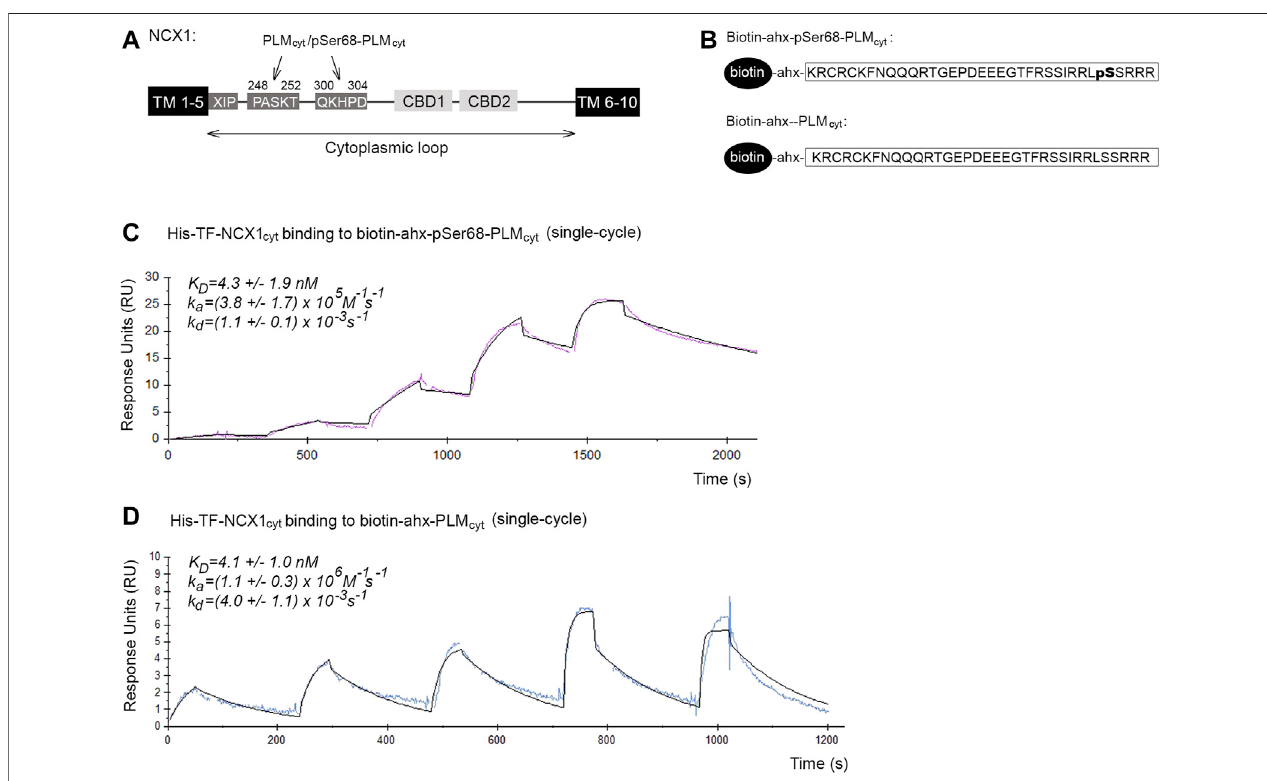
FIGURE 1 | Binding af fi nities and kinetics of the pSer68-PLM-NCX1 and PLM-NCX1 interactions. (A) Illustration of the domain organization in NCX1. NCX1 contains 10 transmembrane (TM) domains, among which a large cytoplasmic loop between TM domains 5 and 6, that plays a regulatory role. The two PASKT- and QKHPD-containing regions in the cytoplasmic loop have been shown to bind directly to PLM/pSer68-PLM (Zhang et al., 2011; Wanichawan et al., 2016). XIP has been shown tobind toanother site inthe cytoplasmicloop, leadingtoNCX1 inactivation (Matsuoka et al., 1997;Maacket al.,2005; Gök et al., 2020).BindingofCa 2+ to CBD1 and CBD2 (calcium binding domain 1 and 2) leads to increased NCX1 activation. (B) Illustration of the two biotin-ahx-pSer68-PLM cyt and biotin-ahx-PLM cyt peptides that were used in Panel (C,D) , Figures 2B – E , 3F , and Supplementary Figure S1A . An ahx-linker was included to avoid any potential steric hindrance. SPR analyses of (C) biotin-ahx-pSer68-PLM cyt and (D) biotin-ahx-PLM cyt immobilized on SA chips and recombinant His-TF-NCX1 cyt protein injected at a range of concentrations over the chips. Red and blue show the experimental data in C ( n (cid:2) 3) and D ( n (cid:2) 5) (single cycles), respectively, whereas the black shows the fi t (mathematical